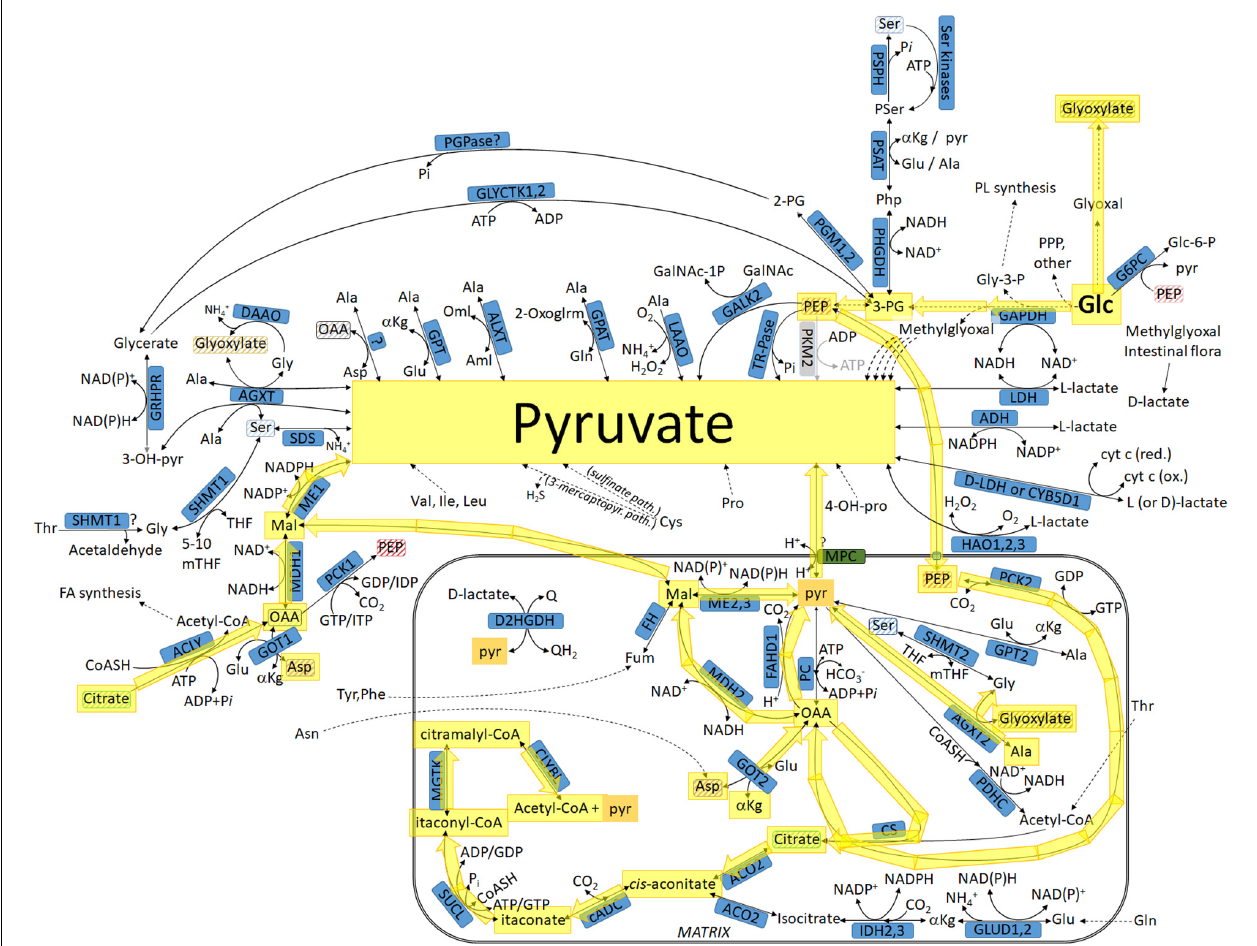
FIGURE 3 | Pathways leading to pyruvate commencing from glucose, highlighted in yellow: intermediates transiting through the mitochondria. For abbreviations, see Table 1 .